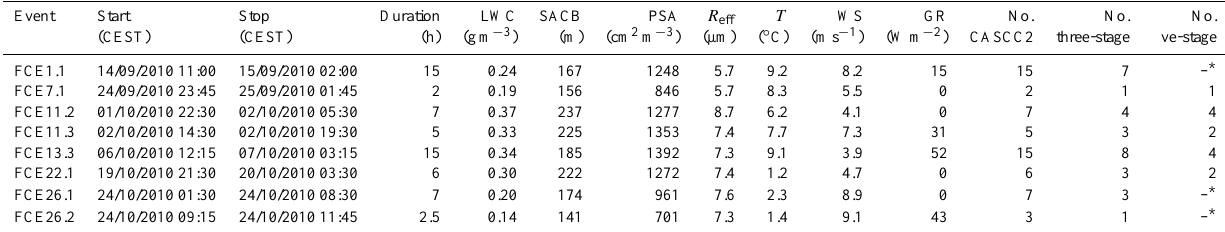
Table 1. Sampling times of cloud water collectors during full cloud events with mean liquid water content (LWC), droplet surface area (PSA), effective droplet radius ( R eff ) , Schmücke above cloud base (SACB), temperature (T), wind speed (WS), and global radiation (GR) at Mt. Schmücke, as well as the number of samples for the different collectors.